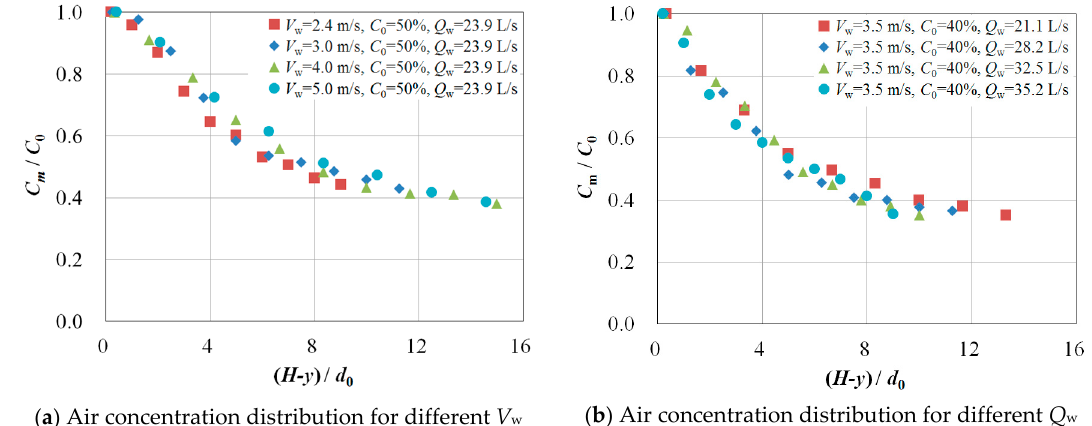
Figure 4. Influence of V w and Q w on axial air concentration distribution.